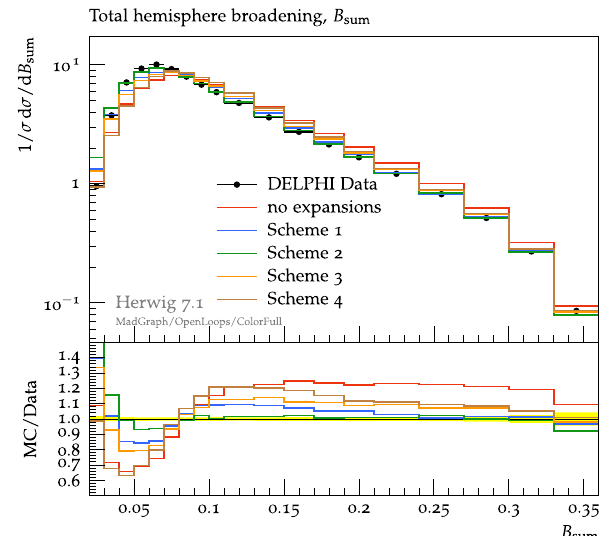
Fig. 11 To illustrate the effects of choosing different schemes of his- tory weight expansions as described in Sect. 4.4, we compare to data from